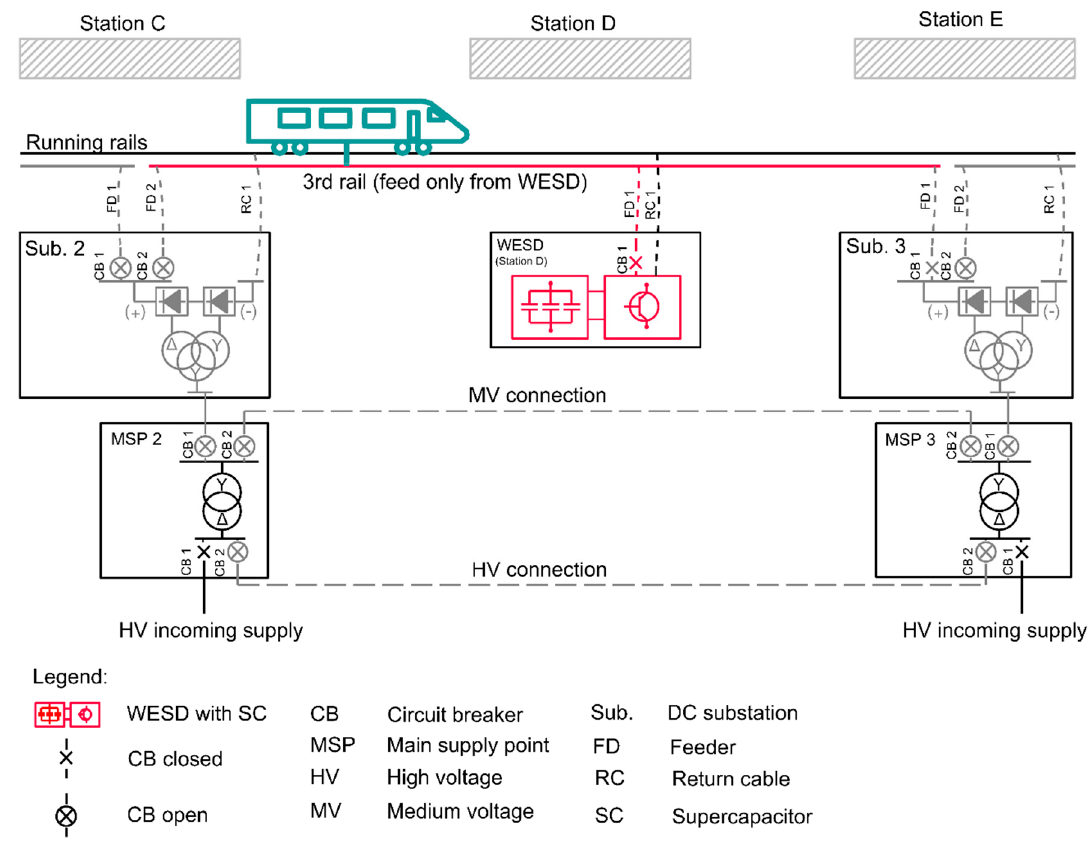
Figure 9. Emergency feeding from WESD.